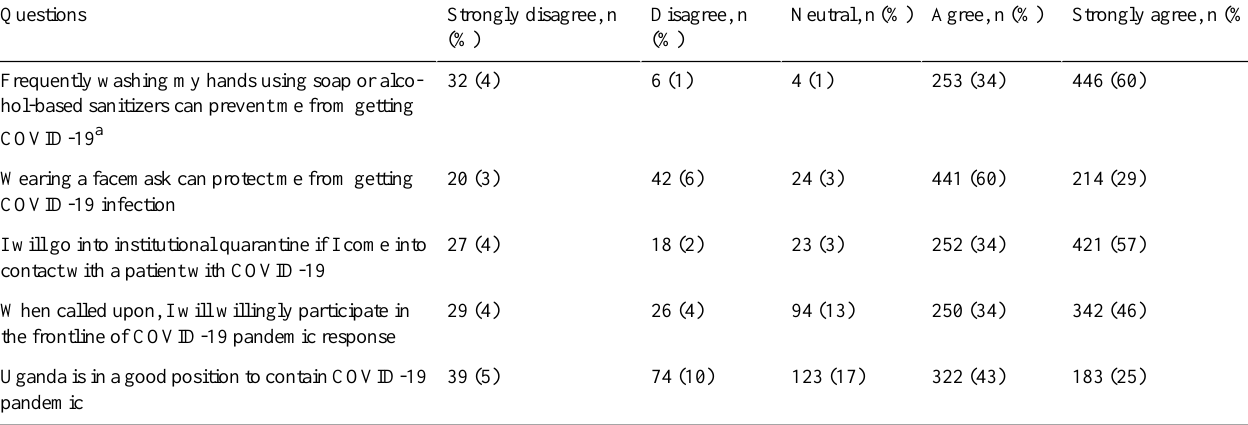
Table 5. Responses of Ugandan medical students (N=741) to questions on attitude toward COVID-19.